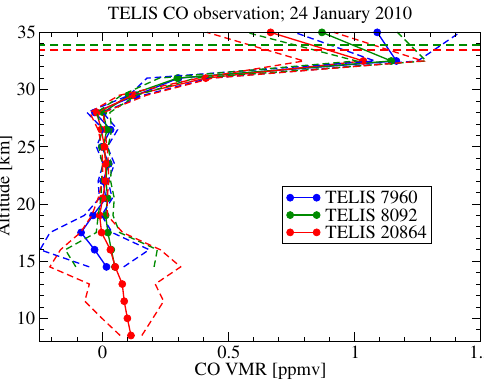
Figure 11. CO VMR profiles estimated from TELIS measurements on 24 January 2010.